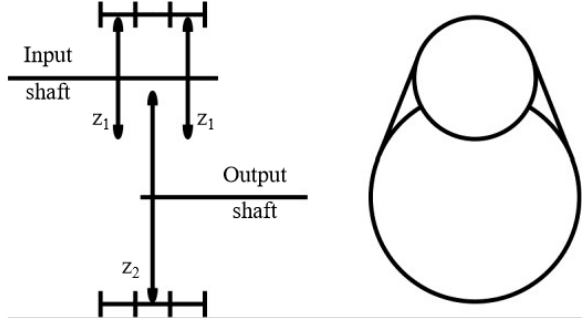
Figure 2. Characteristic of triplex chain transmission.